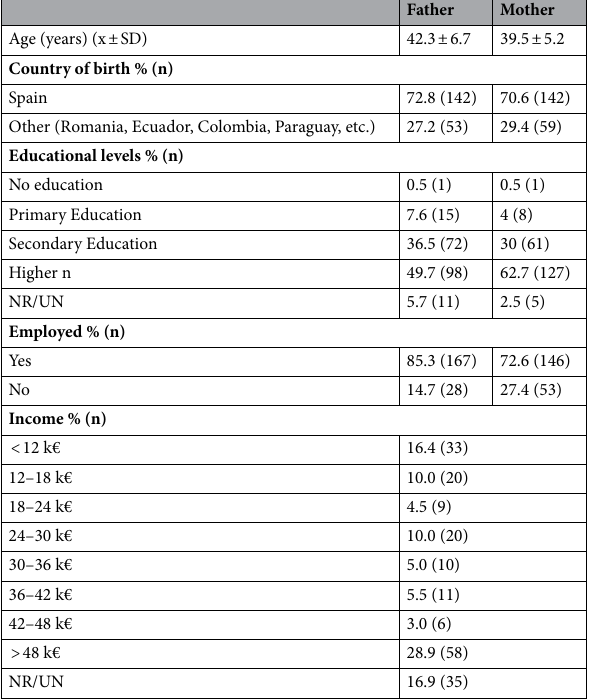
Table 1. Main social and economic characteristics of the families. NR/UN no